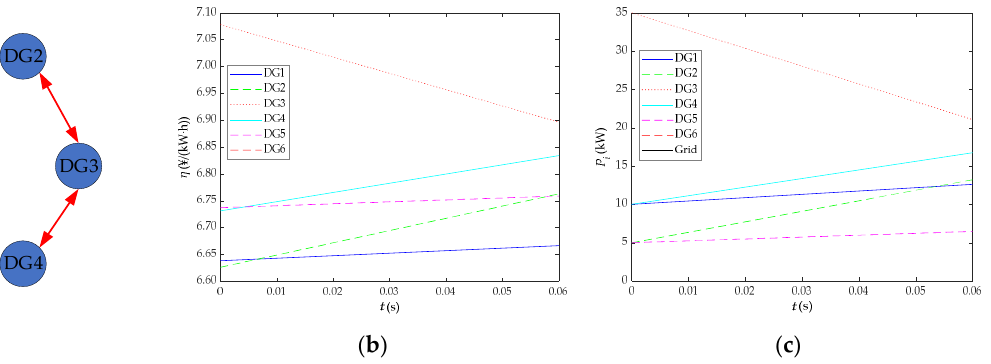
Figure 19. Communication topology and change curves of variables of the system when DG6 exits